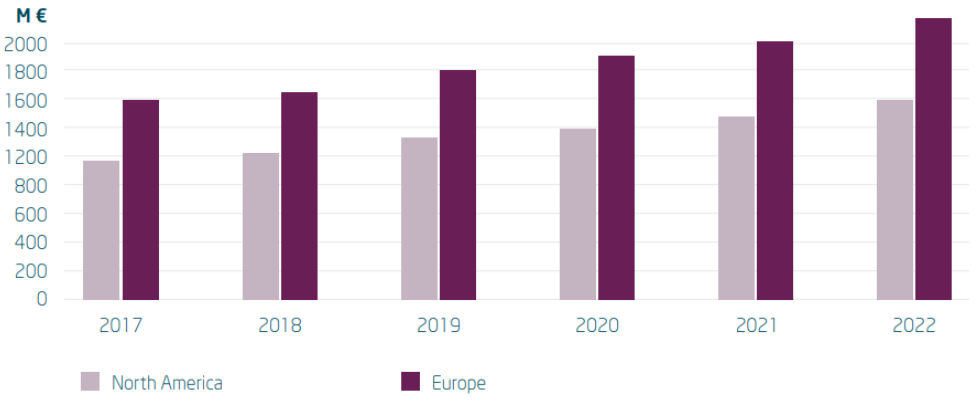
Figure 8. Expected grow of the ITS market [9].